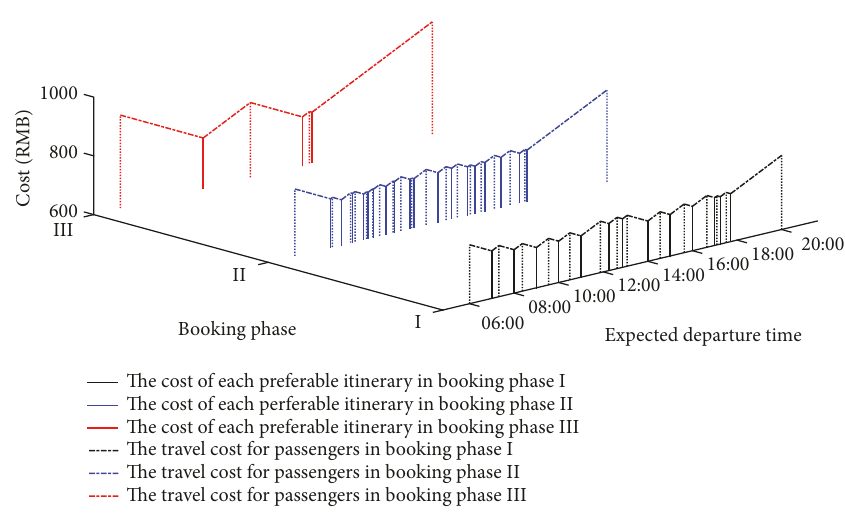
Figure 4: The cost and the expected departure interval of each preferable itinerary in each booking phase from the SBPRA algorithm.